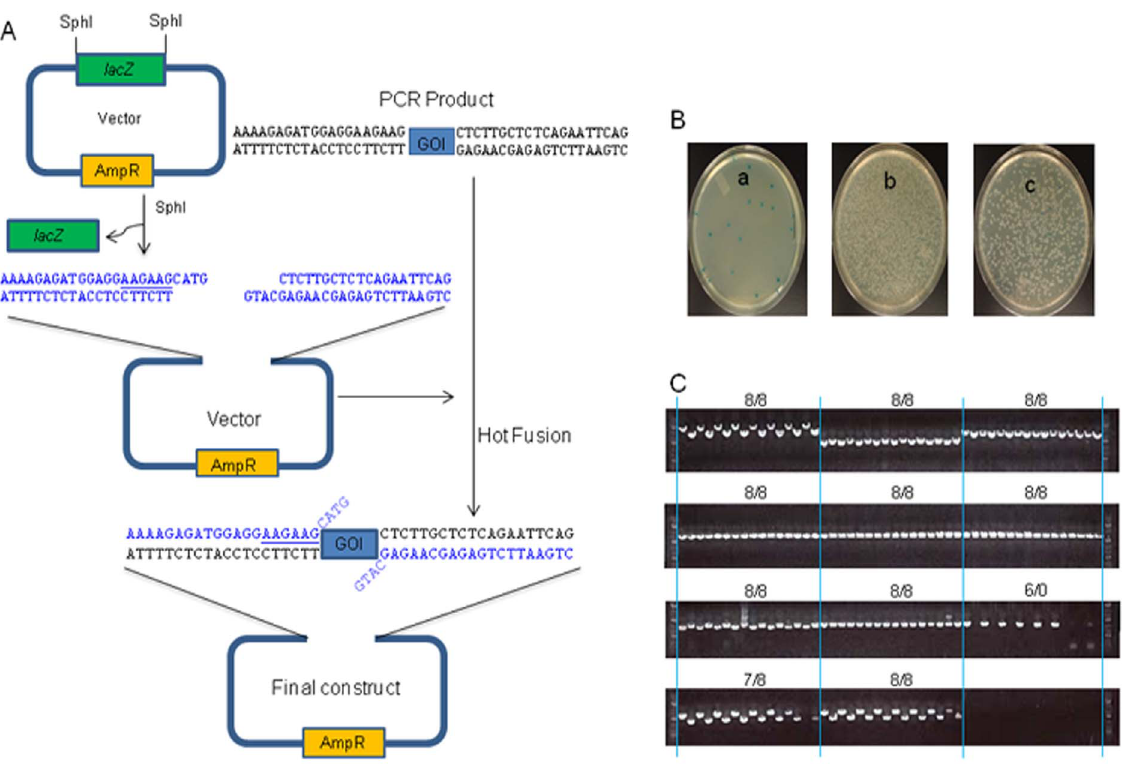
Fig. 4. Creation of seamless constructs by Hot Fusion. (A) A schematic diagram for the creation of a seamless construct. The vector was linearized by SphI digestion (leaving CATG 3 9 overhangs), heat-inactivated and directly used for cloning. The PCR products contain the overlapping sequences at each end (excluding the CATG overhang). The ribosome binding site is underlined. (B) Examples of the transformation plates. Blue colonies contain the parental vector and white colonies contain potential positive clones. The negative control is shown as plate a (unpurified digested vector without added PCR product). Plates, b and c are two examples of transformation plates containing potential positive clones. (C) PCR screening results of 8 colonies for each construct (each plate). Eight PCR products of each construct were loaded every other lane on agarose gels by multi channel